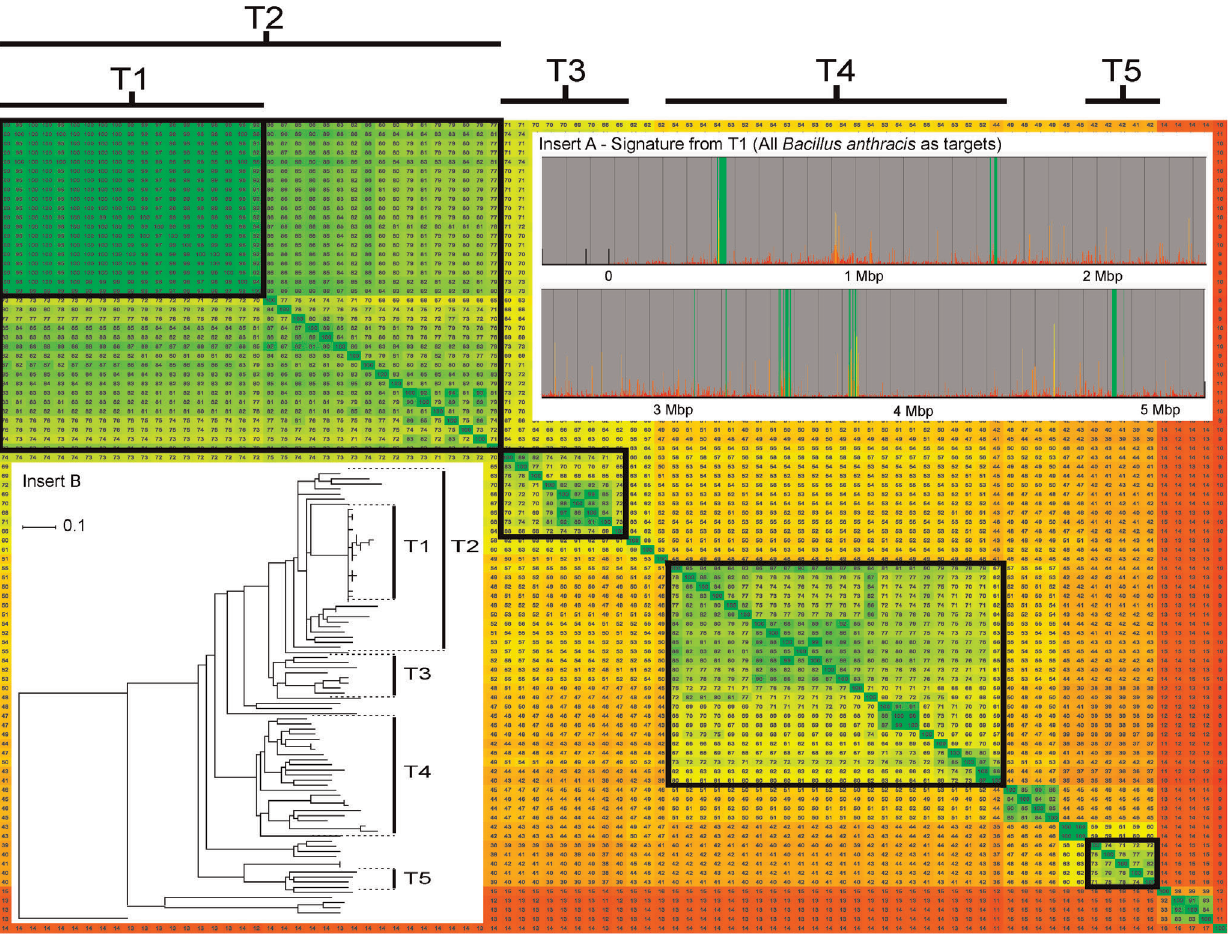
Figure 4. Comparative analysis of the Bacilluscereus group. A heat-plot based on a 200/100 BLASTN fragmented alignment without threshold is shown. The figure is cropped to show only the Bacillus cereus group. Target groups used for PCR design are indicated (T1–T5). All remaining Bacillus genomes were used as a background group. This analysis was made without a threshold to filter non-conserved genetic material. Viewing the heat- plot without a threshold means that the values are based on both the core genome size and the core conservation. This often gives a better view during target group formulation because signatures are per definition outside the core when comparing a target genome with a background genome. Insert A shows the uniqueness signature for B. anthracis (T1). Signatures for all groups are present in Figure S3. Insert B shows a dendrogram based on the heat plot. The dendrogram was produced in SplitsTree 4 (using neighbor joining method) made from a distance matrix Nexus file exported from Gegenees. B. cytotoxicus was set as